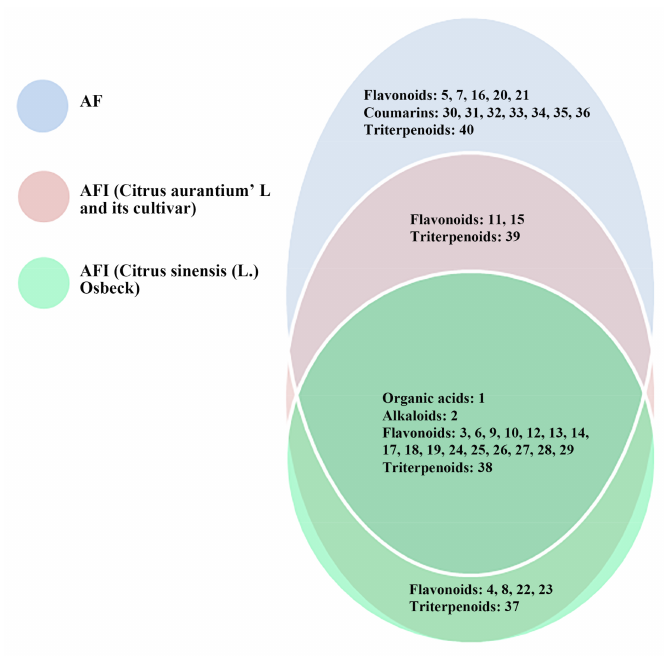
Figure 2. The chemical similarities and differences between AF and